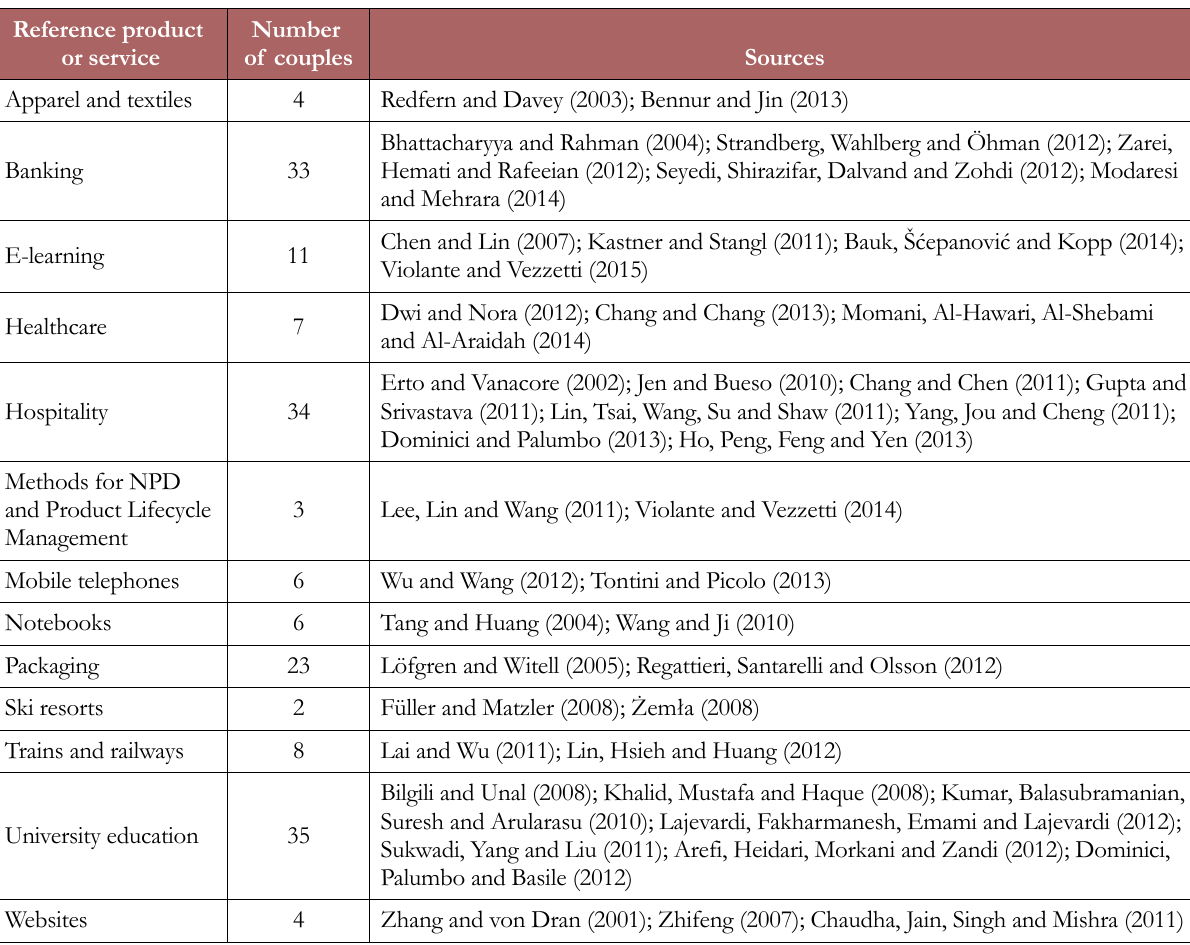
Table 1. Dataset of different Kano surveys investigating akin customer